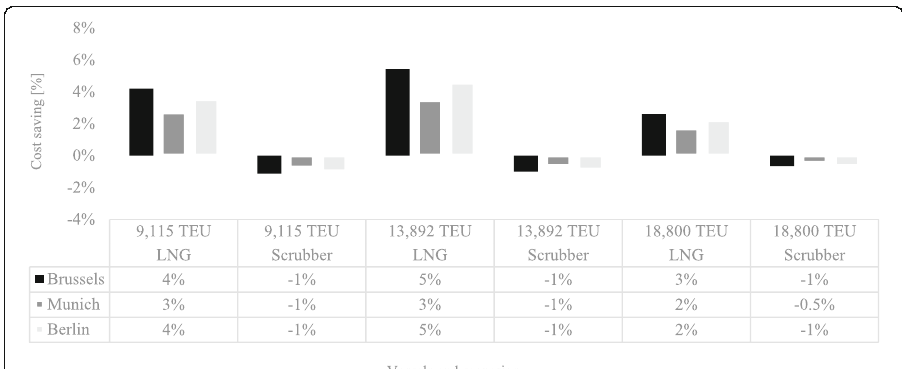
Fig. 5 Relative changes for supply chain cost from Shanghai to EU for different ship types and for LNG and scrubber